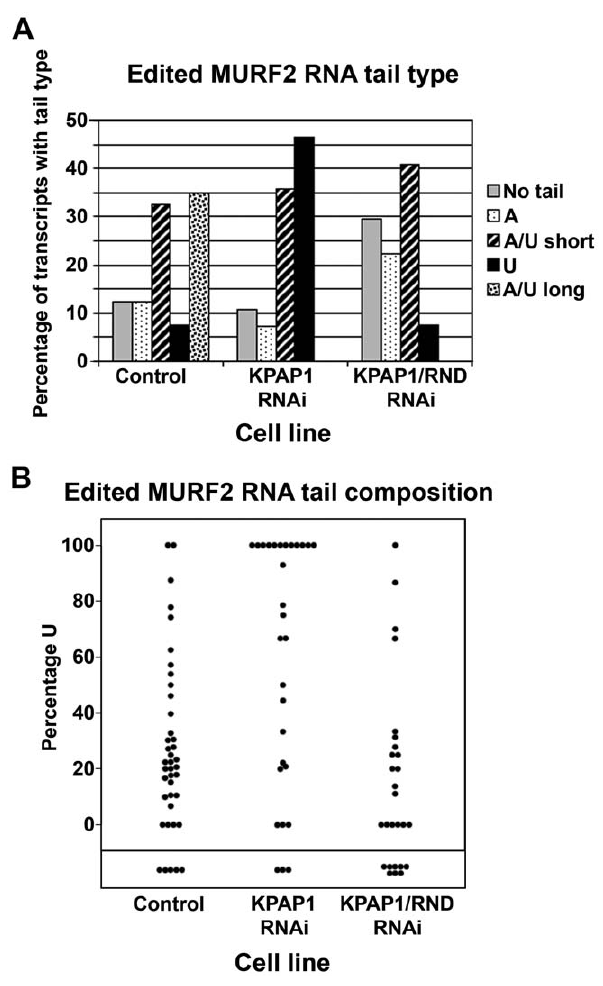
Figure 5. Analysis of edited MURF2 RNA non-encoded tails. A. Percentage of the total population possessing each tail type in cells collected 3 days post-induction of RNAi and in uninduced cells. Total number of tails in each of the three populations ranged from 17 to 26. B. For each non-encoded tail obtained from each cell type, the percentage U in the tail was calculated and plotted. ‘‘Control population’’ is comprised of sequences derived from RNA of uninduced cultures of the TbRND, KPAP1, and KPAP1/TbRND RNAi cell lines.